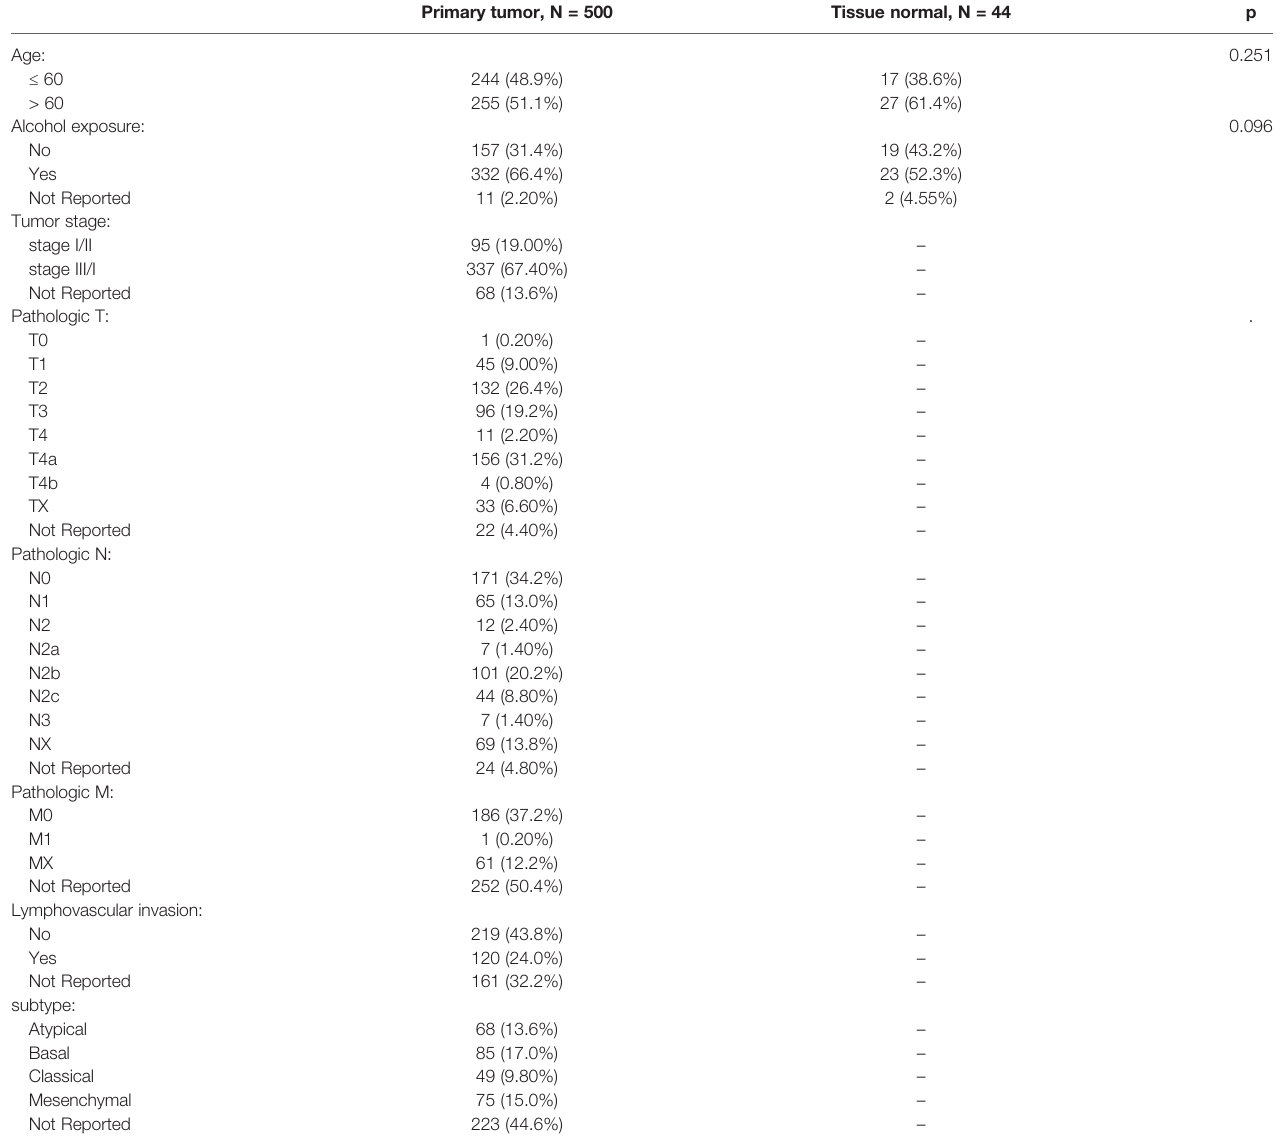
TABLE 1 | Clinical information of HNSCC patients in The Cancer Genome